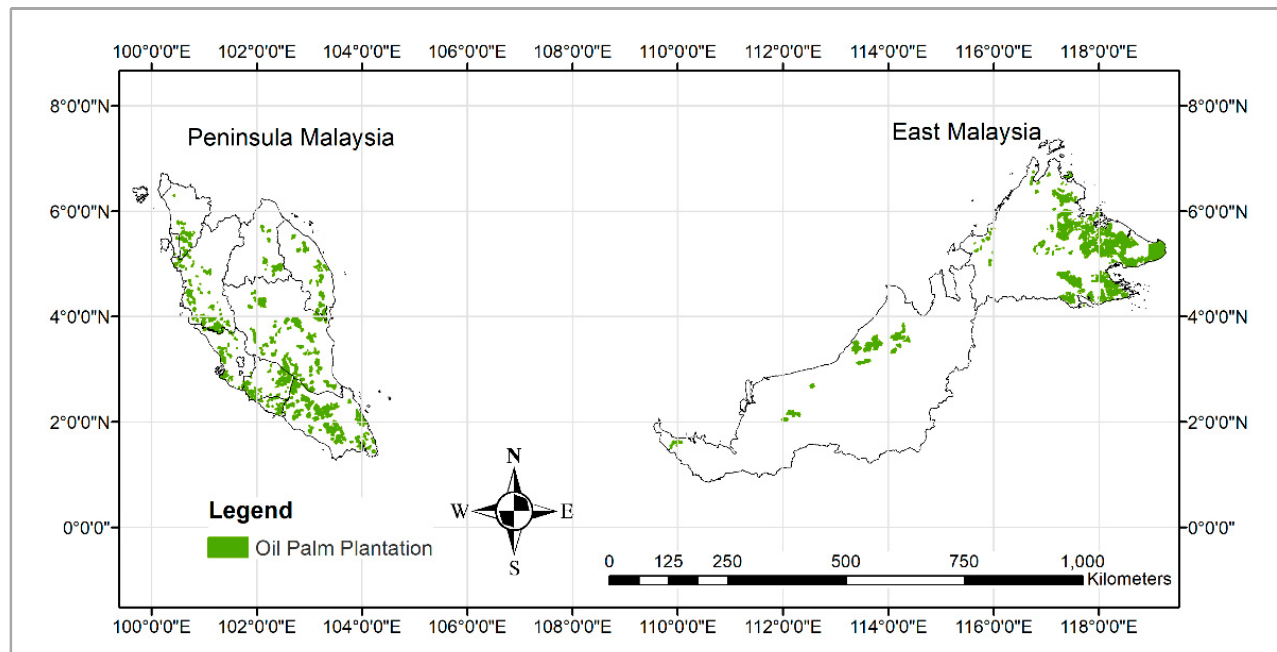
Figure 2. Location map of oil palm plantation areas in Malaysia. Created with data from [32].